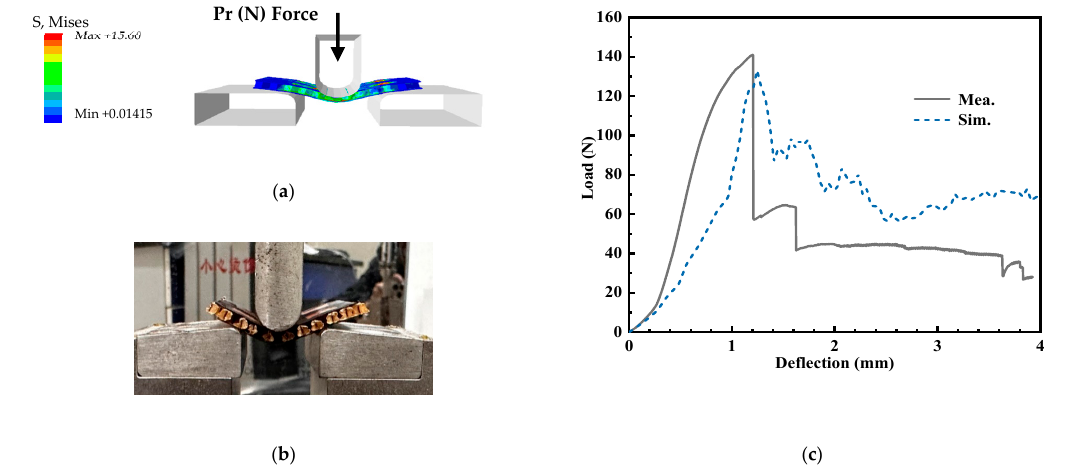
Figure 18. The three-point bending test of single-layer honeycomb sandwich panel, ( a ) simulation model ( b ) experiment environment, and ( c ) load–deflection relationships.